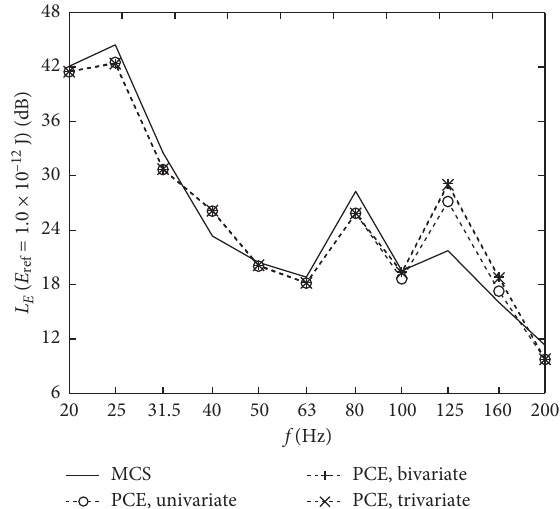
Figure 9: SE of the energy-level response of the 1/3 Oct